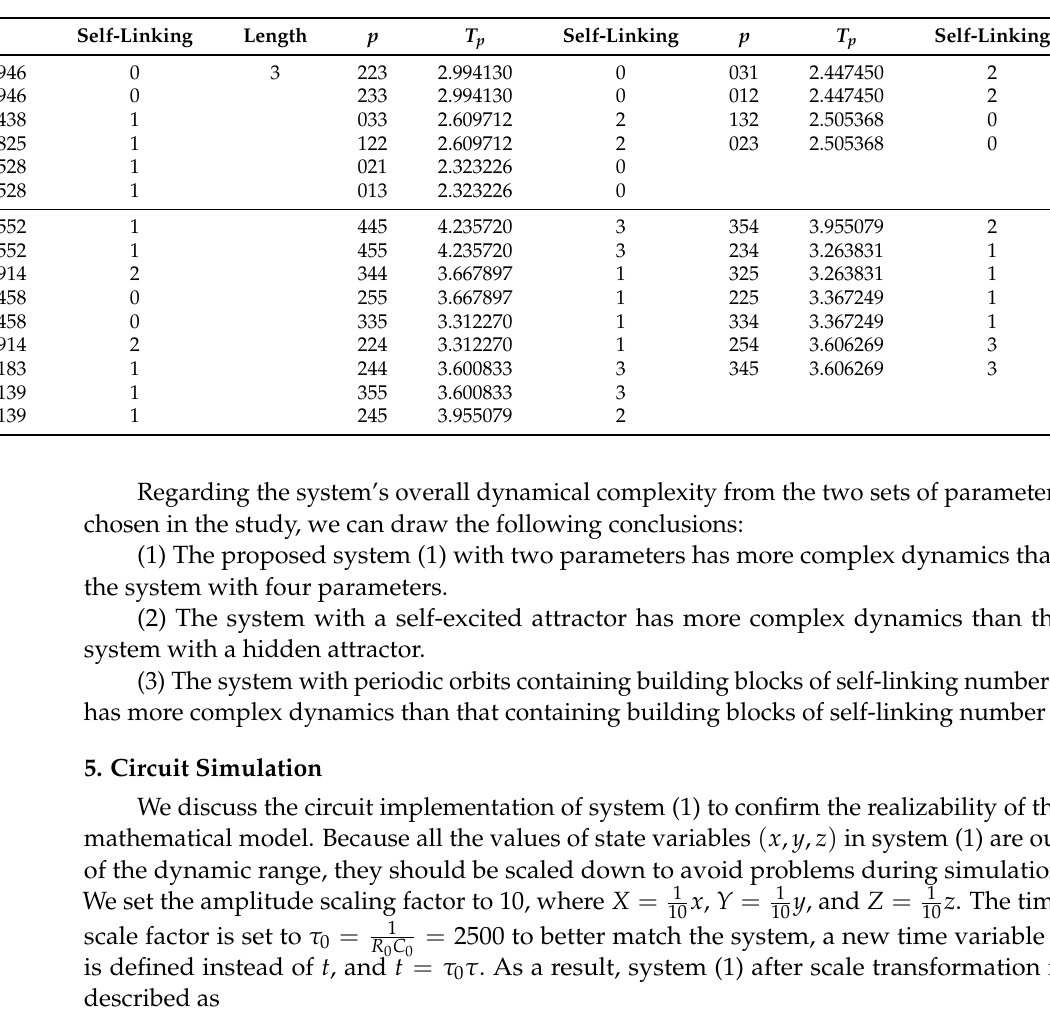
Figure 18. Unstable periodic orbits in system (1) for parameters ( a , b , c , k ) = ( 10,64,0,0 ) . Two equilibria are marked with “+". ( a ) cycle 24; ( b ) cycle 25; ( c ) cycle 45; ( d ) cycle 033; ( e ) cycle 021; ( f ) cycle 132; ( g ) cycle 324; ( h ) cycle 255; ( i ) cycle 335; ( j ) cycle 325; ( k ) cycle 225; ( l ) cycle 254. Table 2. Forty-one unstable periodic orbits embedded in self-excited chaotic attractor of system (1) for ( a , b , c , k ) = ( 10,64,0,0 )